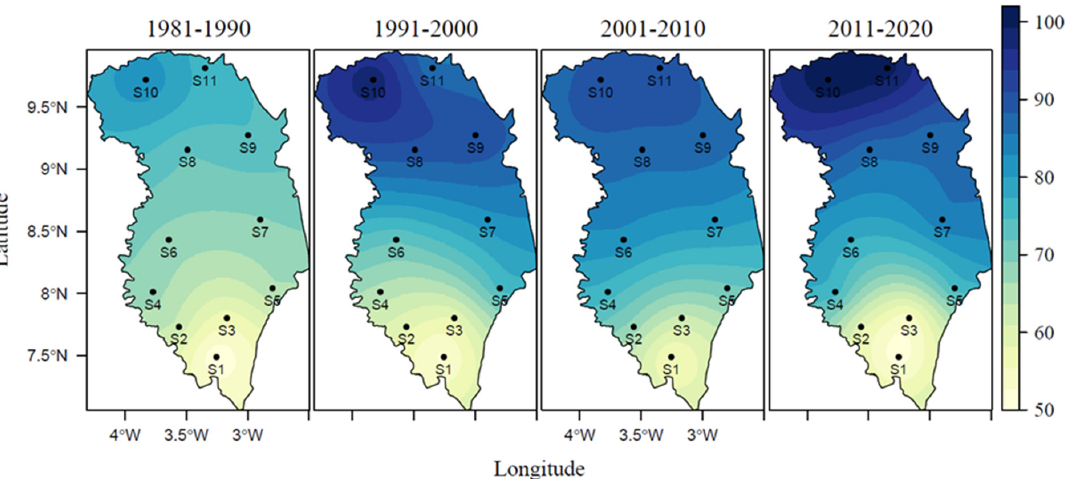
Figure 5. Spatial distribution of the consecutive dry days (CDD) (days) per decade in the Zanzan region. Stations (S1 = Koun Fao, S2 = Kouassi-datékro, S3 = Tanda, S4 = Sandegué, S5 = Bondoukou, S6 = Nassian, S7 = Sapli, S8 = PN Comoé S1, S9 = Bouna, S10 = Téhini, S11 = Doropo).